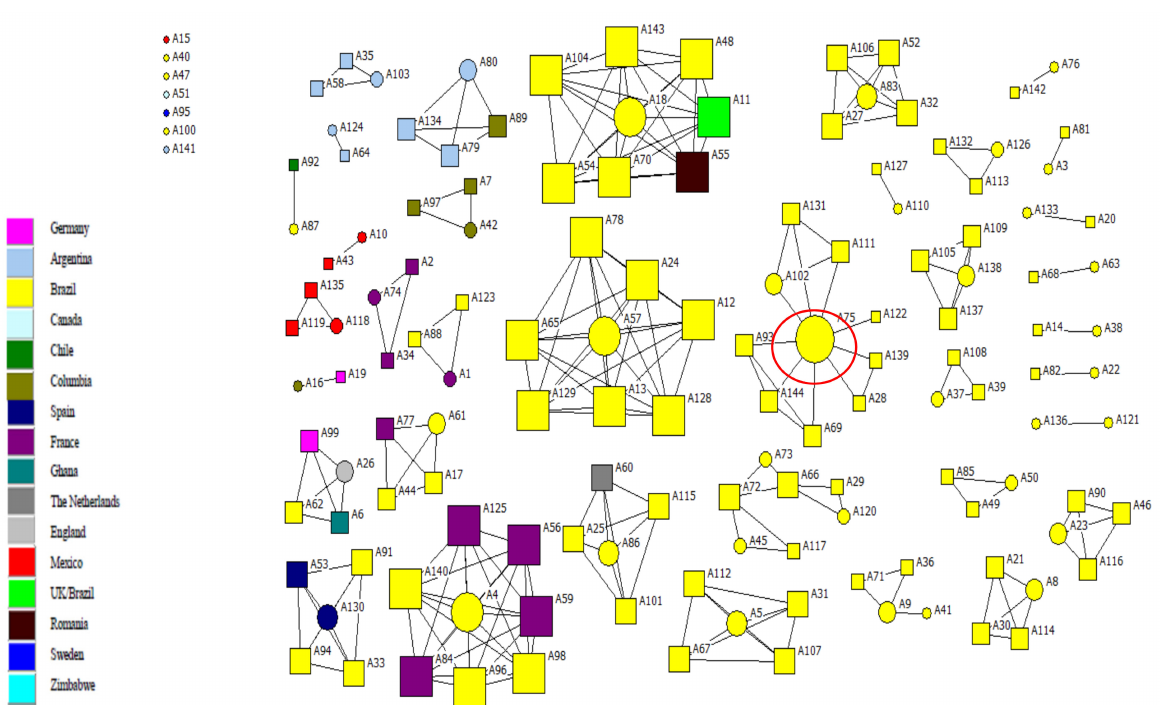
Figure 3. Connection map of publications between authors. Circles indicate first author and squares indicate other